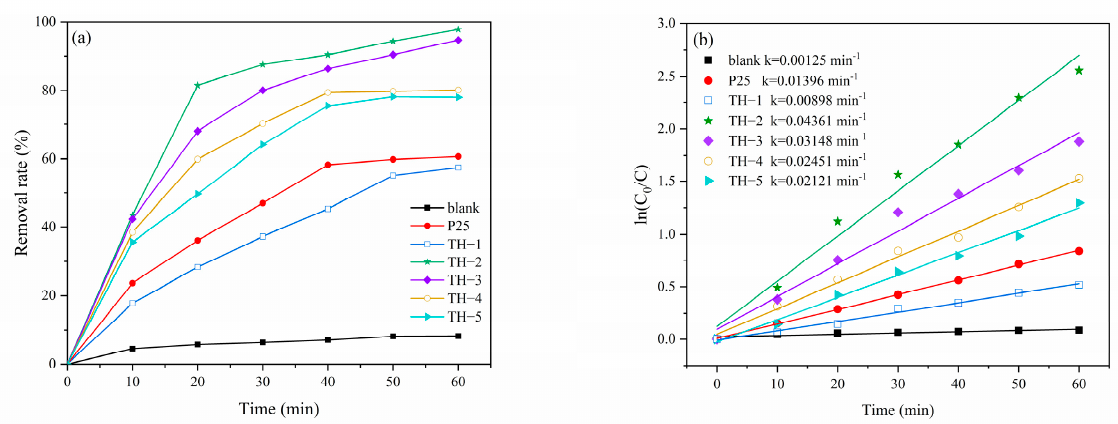
Figure 8. ( a ) Photocatalytic degradation of MB under UV light; ( b ) the first-order kinetic fitting curve of the photocatalytic MB degradation.